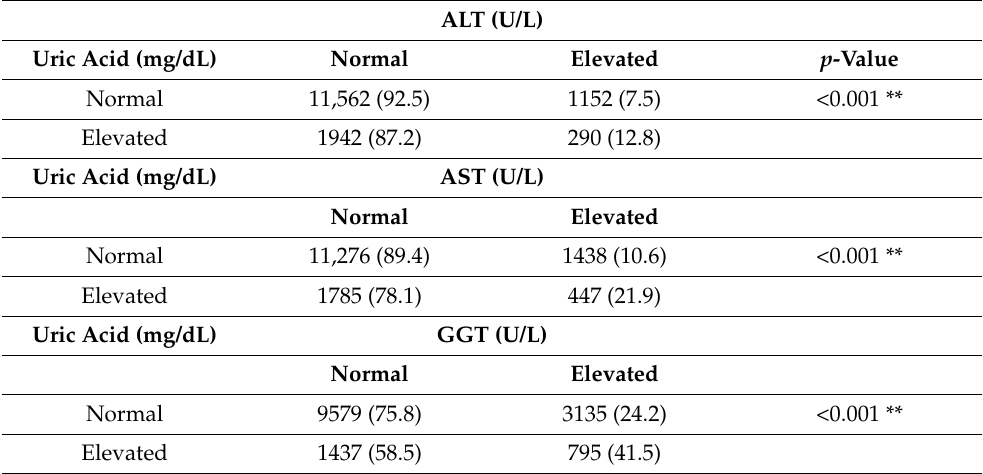
Table 3. Association between Hyperuricemia and Liver Enzymes (Gender-based cut-off